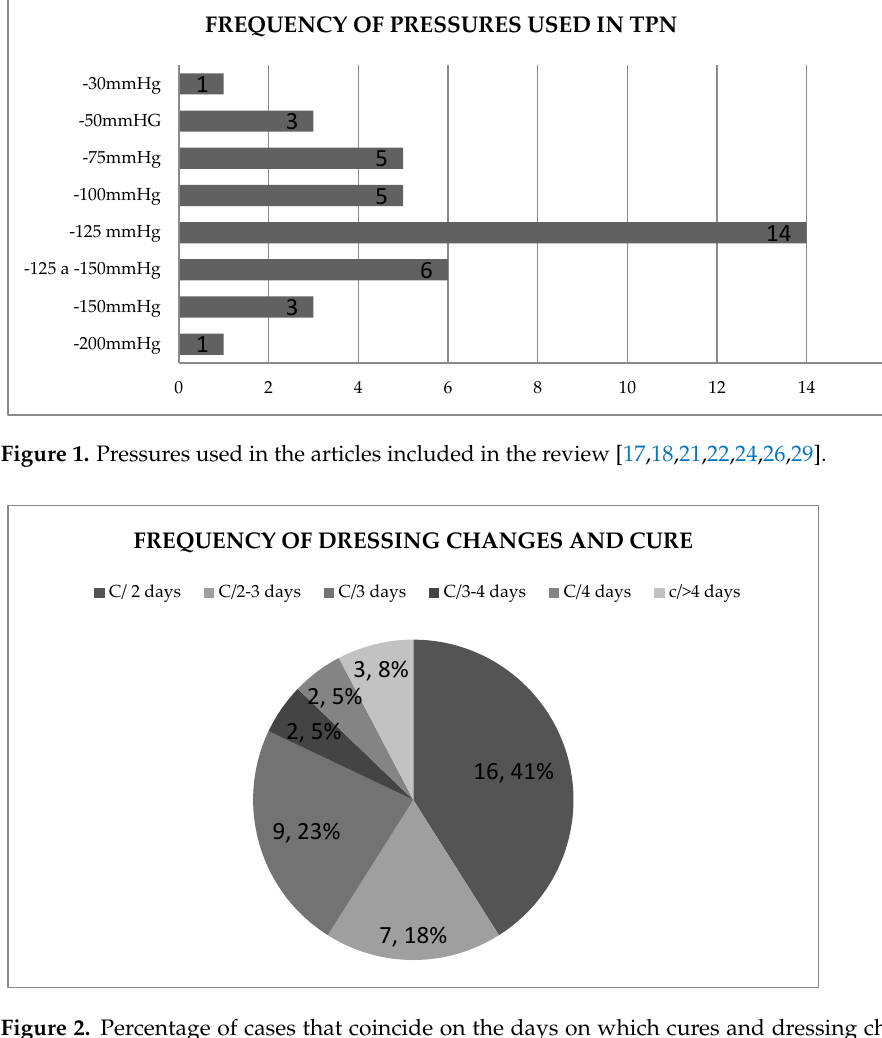
Figure 2. Percentage of cases that coincide on the days on which cures and dressing changes are